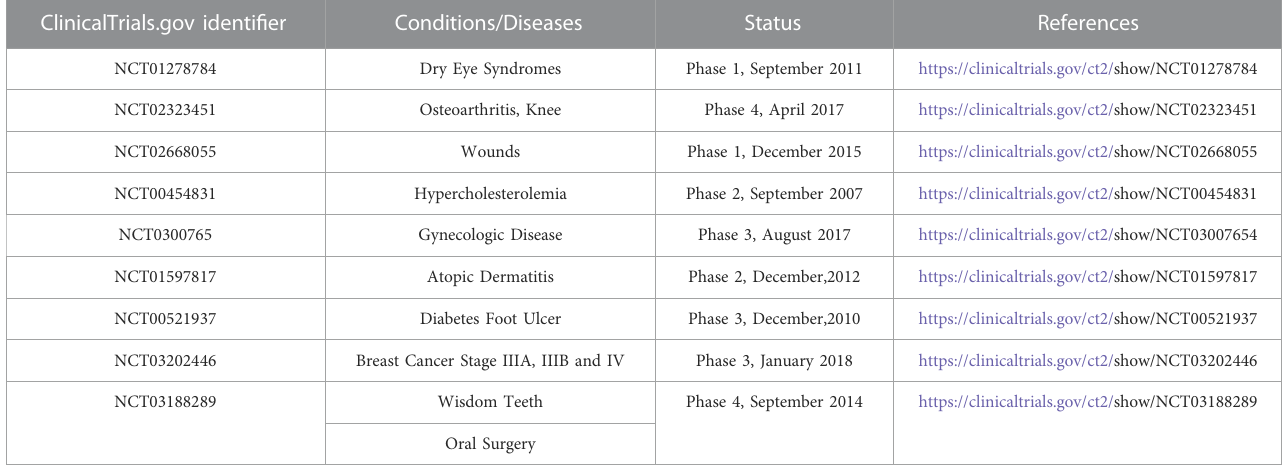
TABLE 1 An overview for clinical trials of chitosan and derivatives. ClinicalTrials.gov identi fi